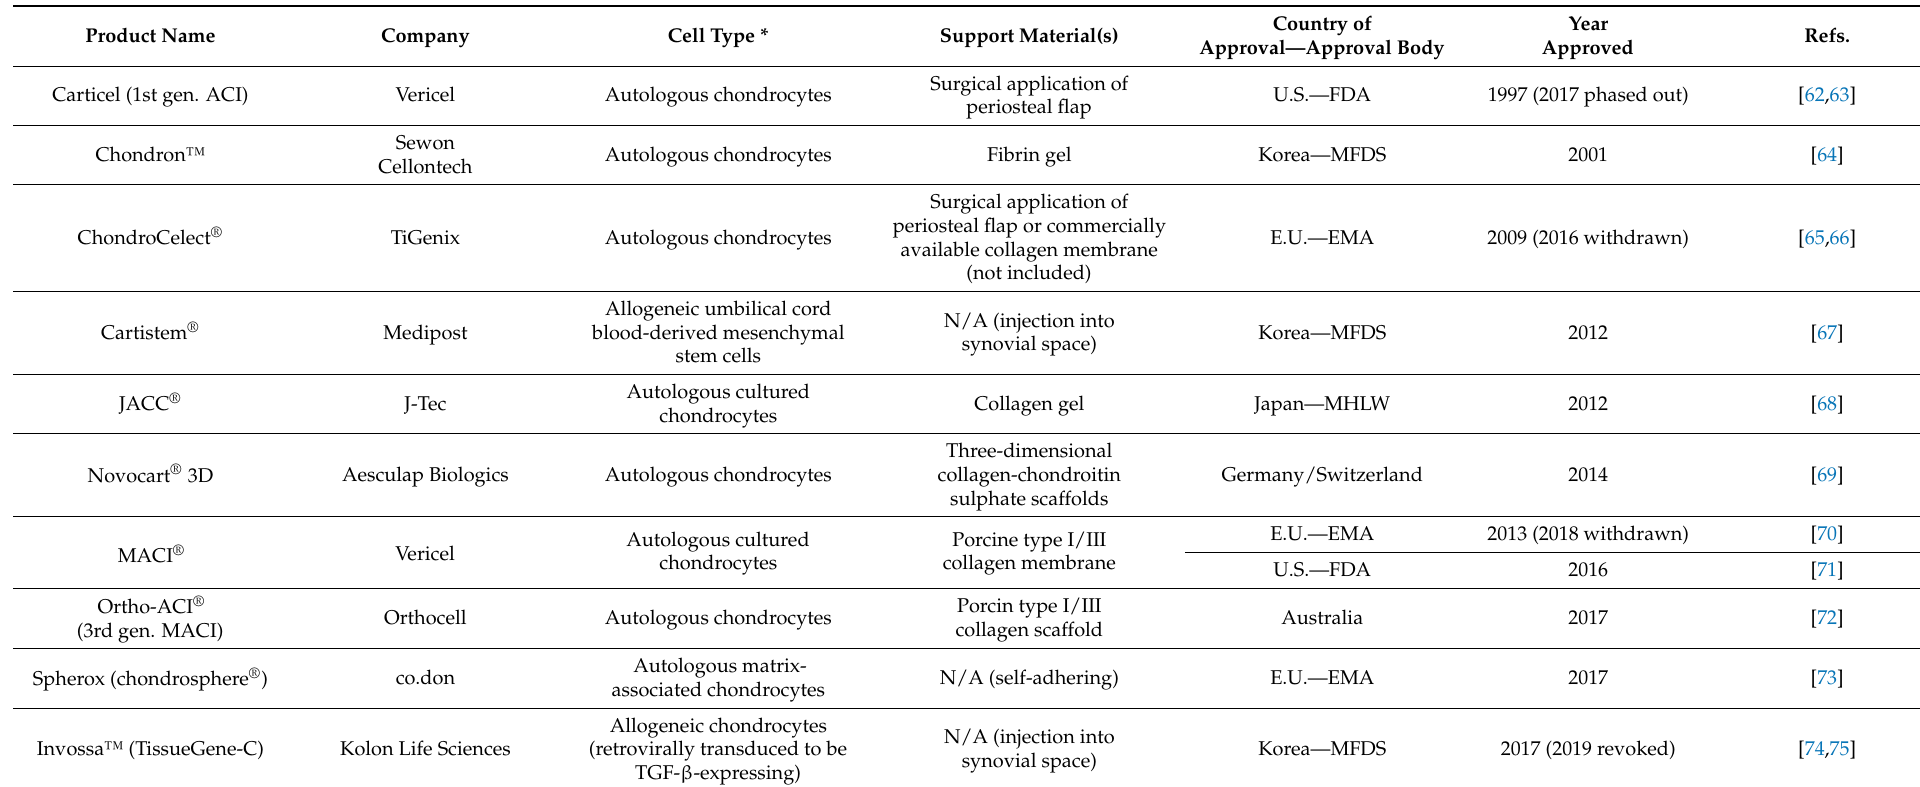
Table 1. Clinically approved cell and tissue engineered cartilage regeneration